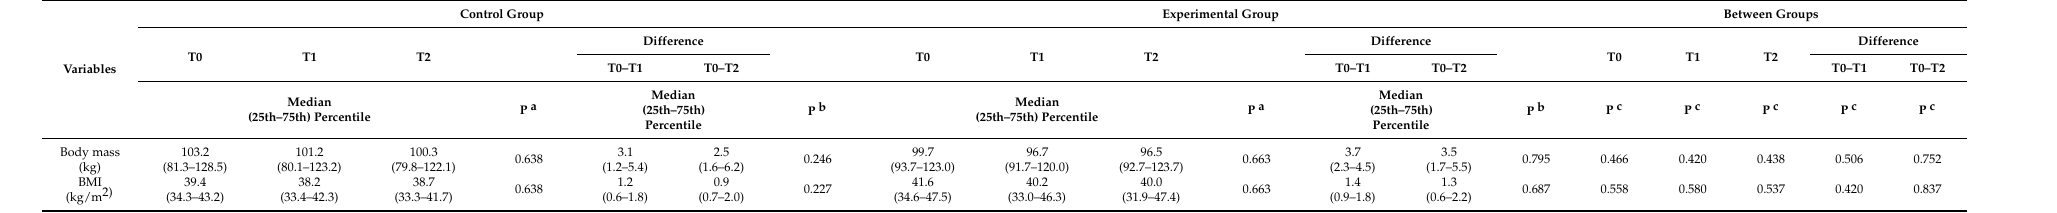
Table 2. Changes in patients’ anthropometry and blood pressure during the trial, and comparison between groups.